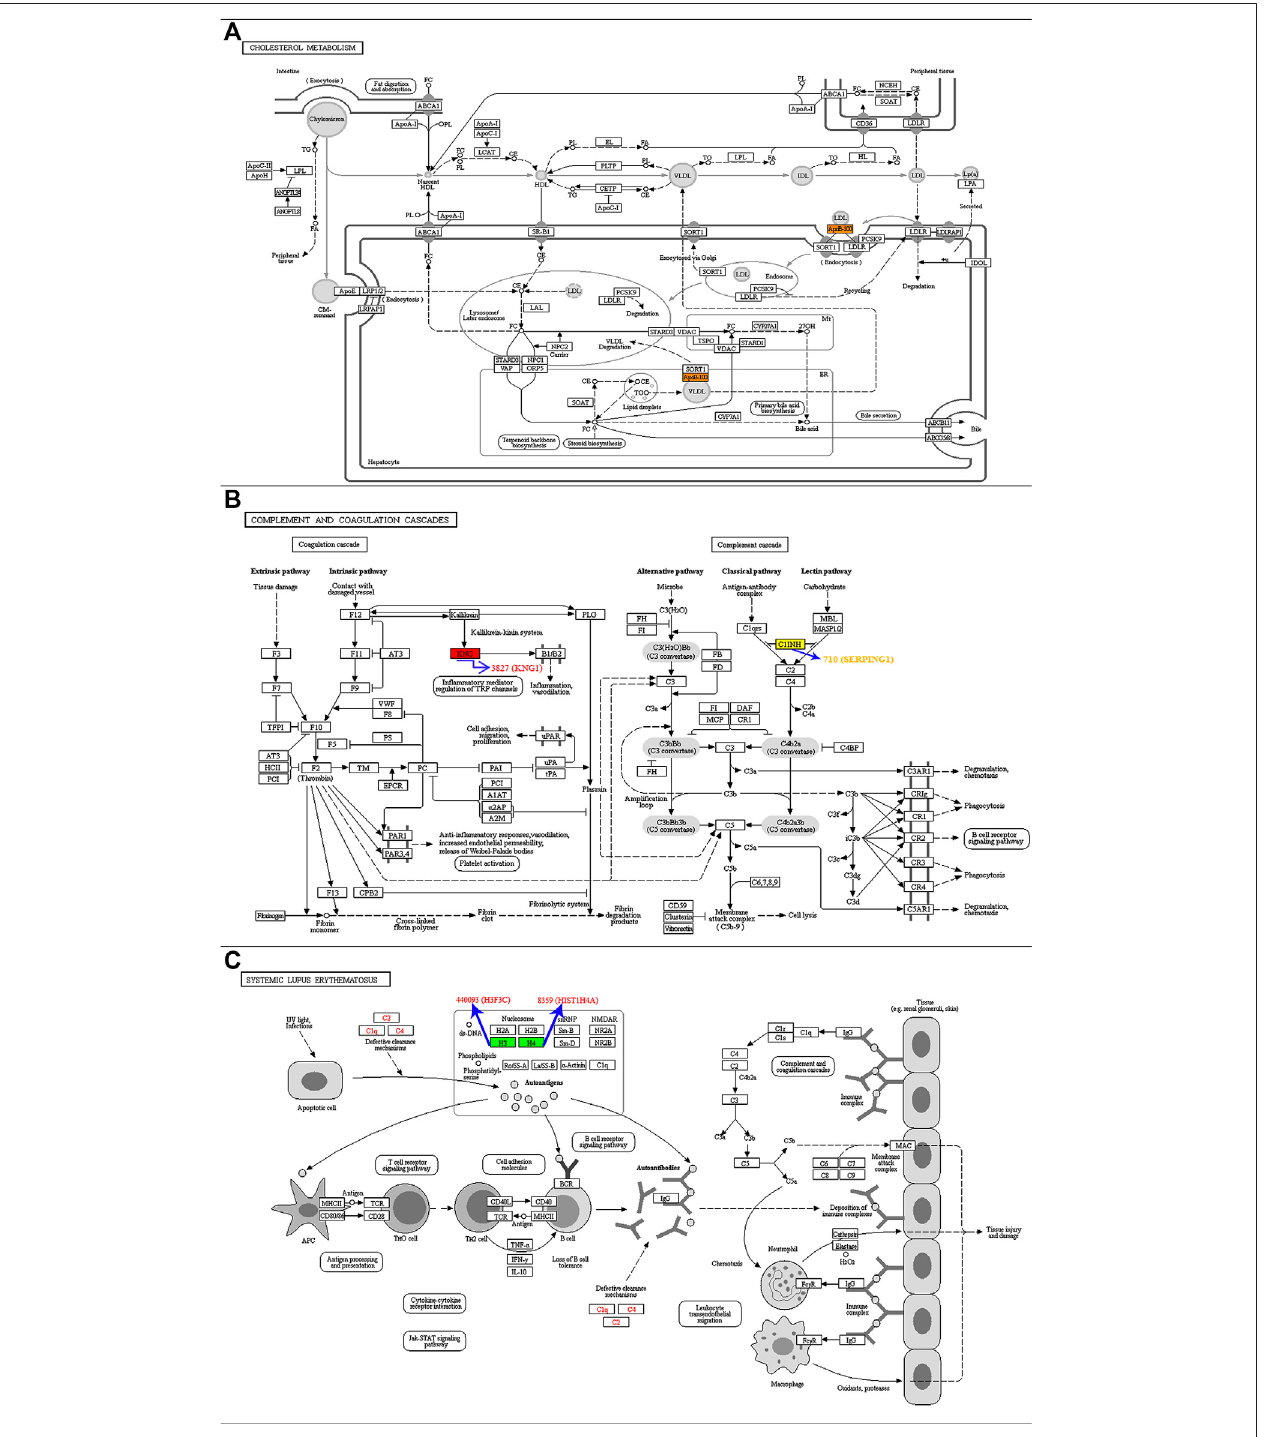
FIGURE5| KEGGpathwaymapshowingsigni fi cantenrichmentofproteinscorrespondingtodifferentiallyexpressedmodi fi cationsites. (A) ApoB-100proteinwas enriched into the has04979 pathway. (B) KNG1 and SERPING1 proteinswere enriched into the has04610 pathway. (C) Histones H4and H3.3Cwere enriched into the has05322